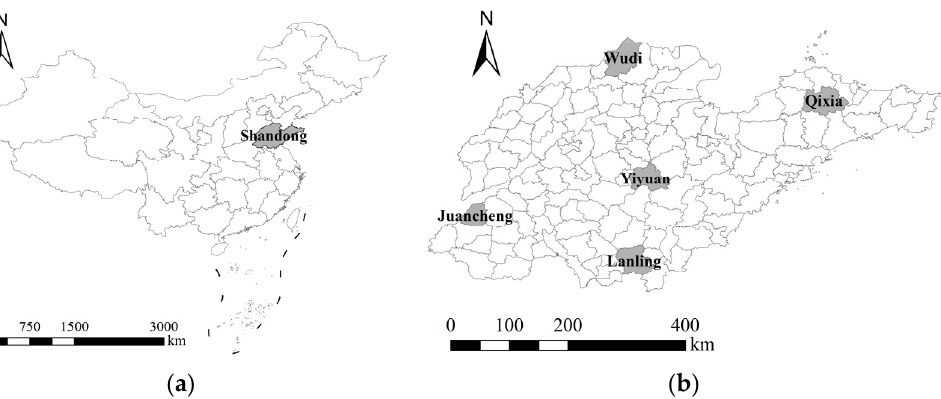
Figure 2. Sample location ( a ) The location of Shandong Province; ( b ) The five randomly selected counties in Shandong Province.